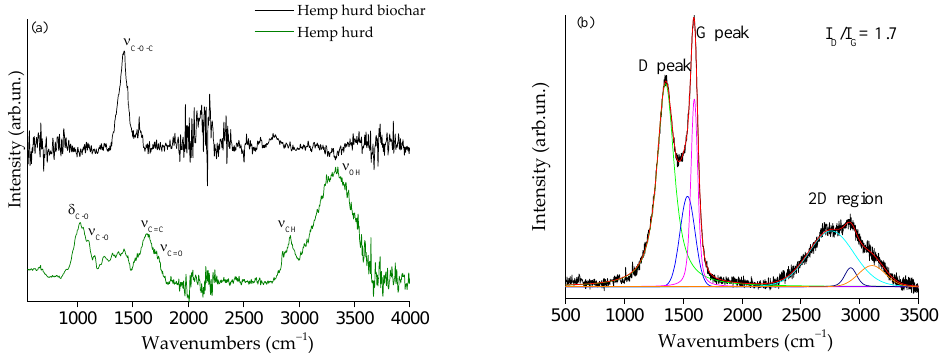
Figure 2. FT-IR spectra of ( a ) hemp hurd (green line) and hemp hurd biochar (black line) in the range from 500 to 4000 cm −1 ; ( b ) Raman spectrum of hemp hurd biochar in the range from 550 to 3500 cm −1 .